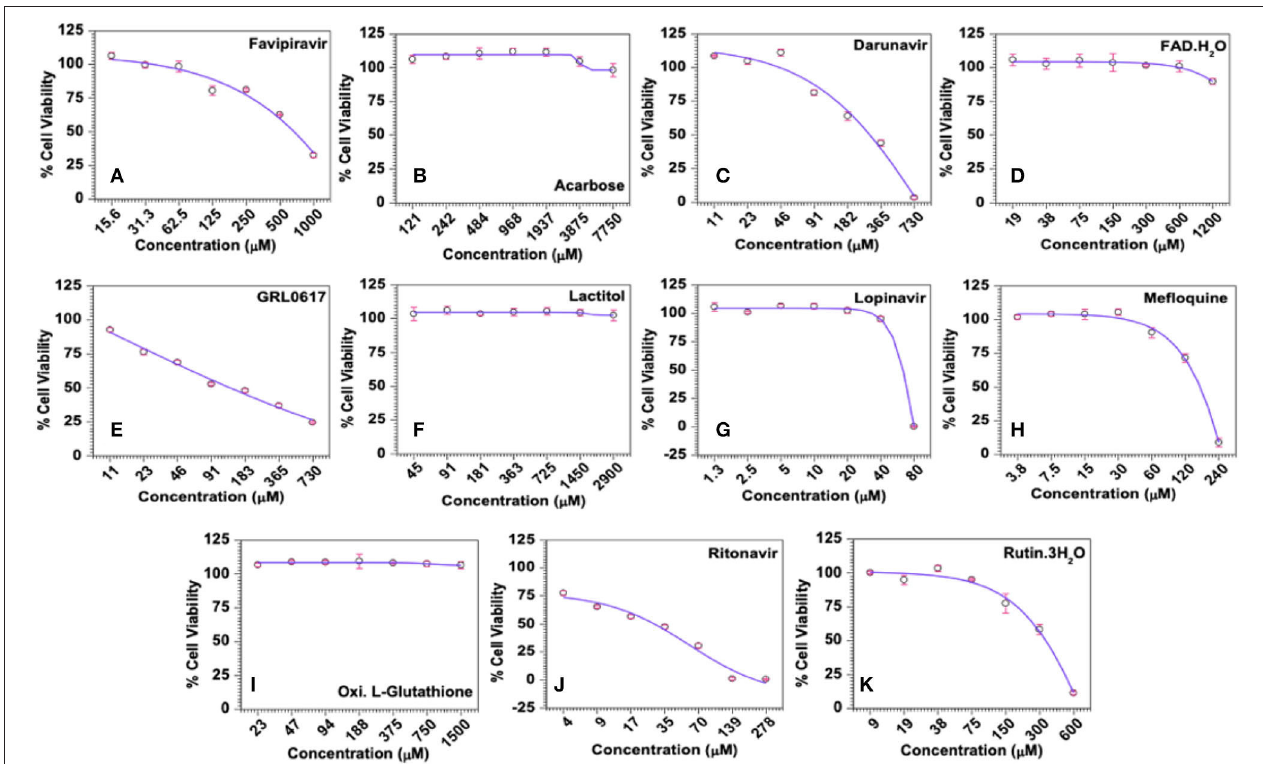
FIGURE 7 | Cytotoxicity profiles of the selected compounds in MRC-5 cells in vitro . (A) Favipiravir (used as known reference control), (B) Acarbose, (C) Darunavir, (D) FAD hydrate, (E) GRL0617, (F) Lactitol, (G) Lopinavir, (H) Mefloquine, (I) Oxidized L-Glutathione, (J) Ritonavir, and (K) Rutintrihydrate were incubated with MRC-5 cells at the indicated concentrations for 6 days at 37 ◦ C in a CO 2 incubator and the cell viability was analysed quantitatively by the colorimetric MTT assay as described in Methods. The raw data were converted to % cell viability and plotted against the indicated doses. Experimental data sets were modelled using a logistic regression model and the 50% cytotoxic concentrations (CC 50 ) were